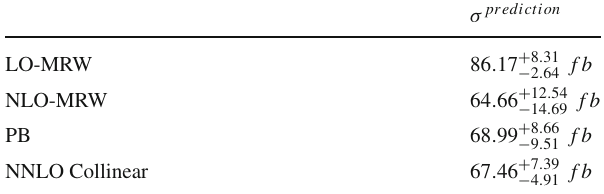
Table 1 Predictions of different UPDFs models an the NNLO collinear for the inclusive fiducial of three-photon cross section. The upper and lower limit of the cross section is due to scale